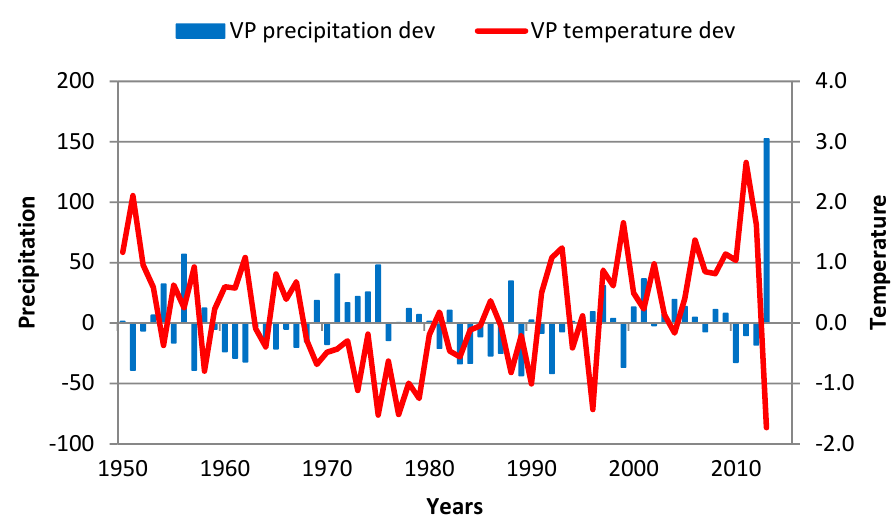
Figure 10. GS precipitation and temperature deviations in Kukavica over the 1951–2013 period. Red line—GS temperature deviation; blue bar—GS precipitation deviation.